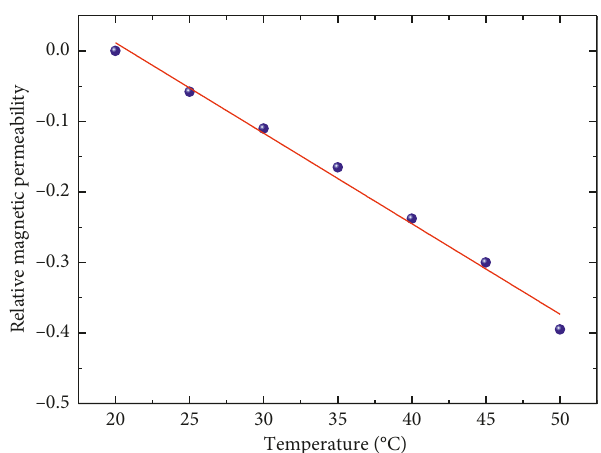
Figure 4: Temperature vs. permeability relationship. Table 1: Integral voltages of specimen with various ambient media (unit: voltage).